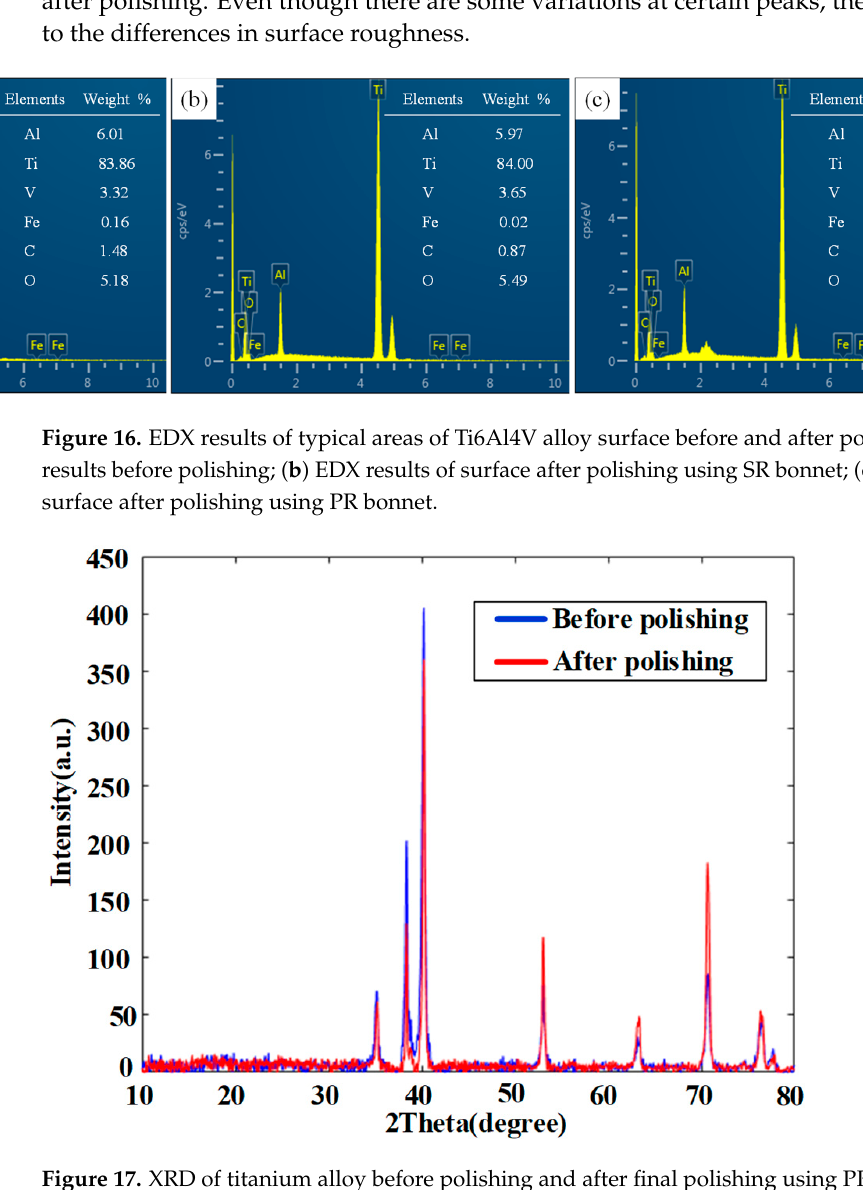
Figure 17. XRD of titanium alloy before polishing and after final polishing using PR bonnet.